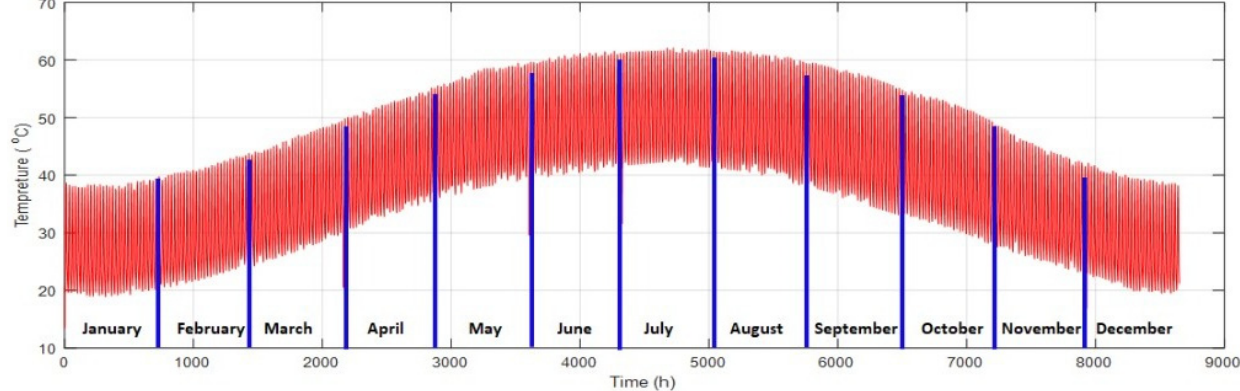
Figure 19. The temperature inside the SHC over a one-year period.